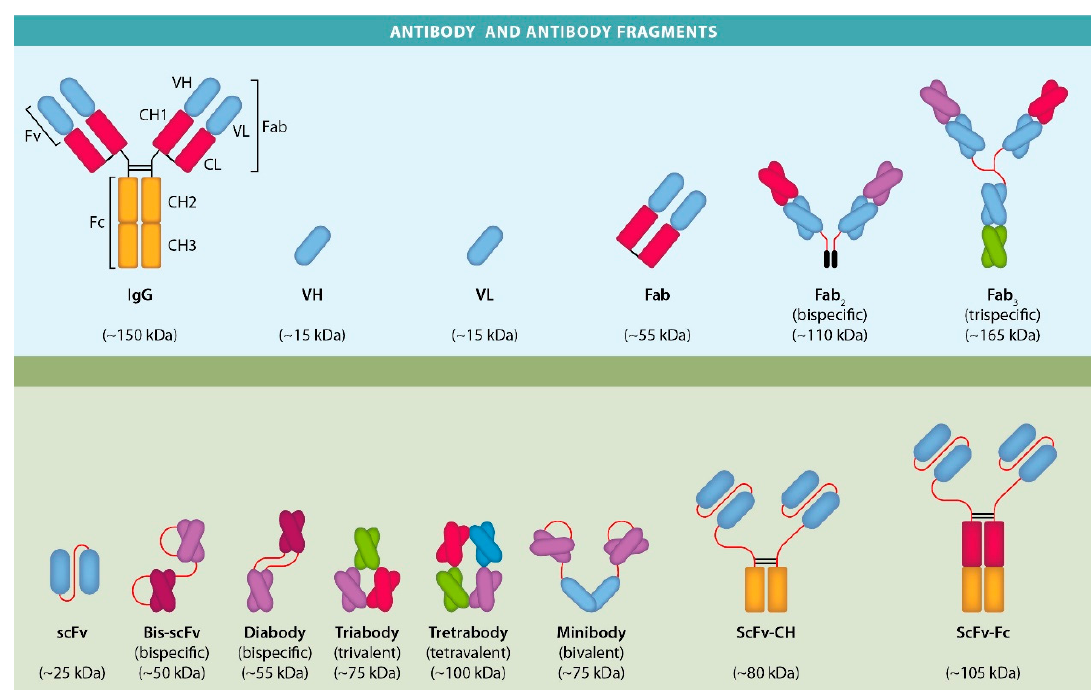
Figure 1. The schematic representation of an antibody and its derivatives. A classic molecule of an IgG antibody is shown with the different fragments obtained from the antibody through genetic engineering.